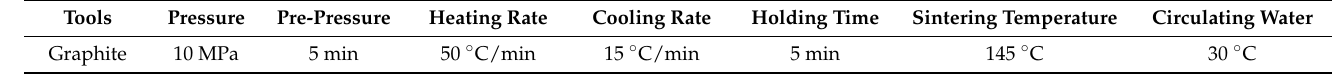
Table 2. The moulding parameters of the SPS